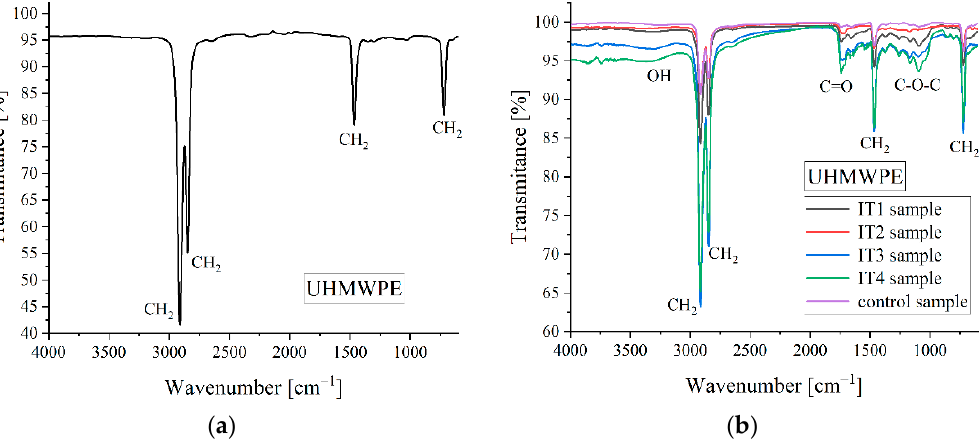
Figure 12. Spectra for the UHMWPE. ( a ) Standard ideal FTIR spectrum for unoxidized UHMWPE sample [92]; ( b ) FTIR spectra for the control and retrieved UHMWPE samples.